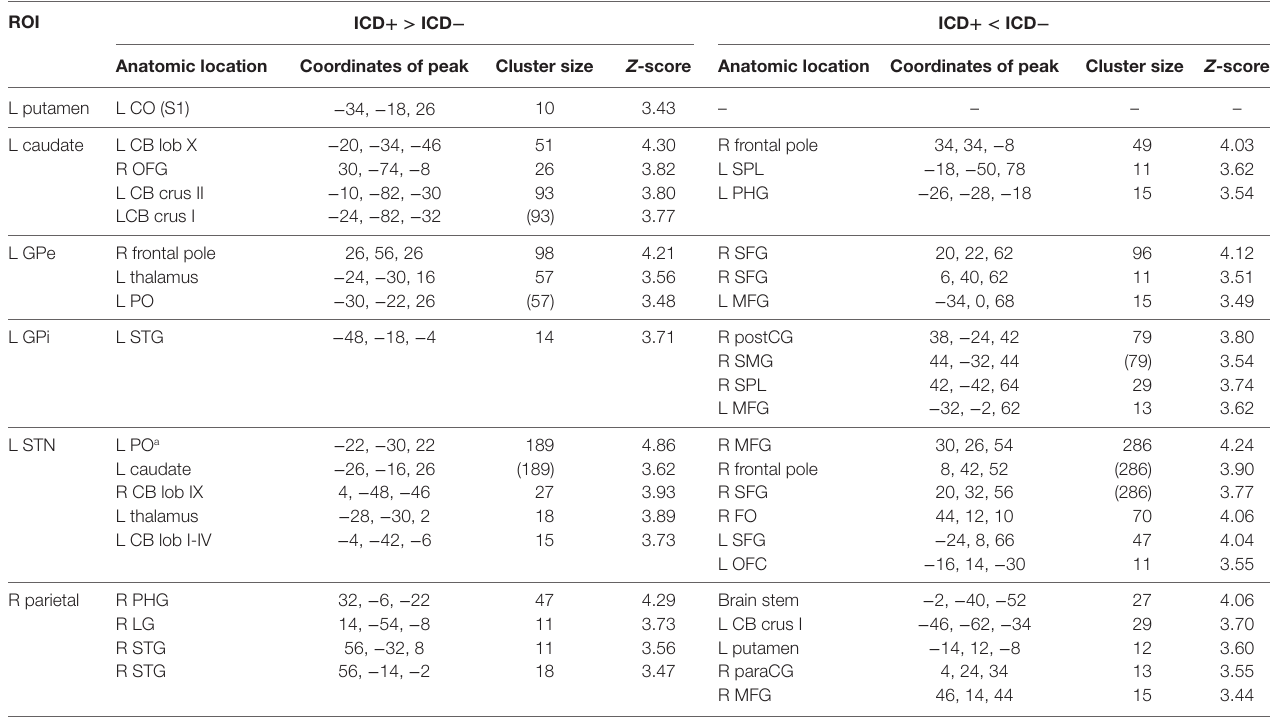
Table 2 | Regions that showed differences in connectivity to the region of interest (ROI) between the impulse control disorder (ICD) + group and the ICD − group. rOi icD + > icD